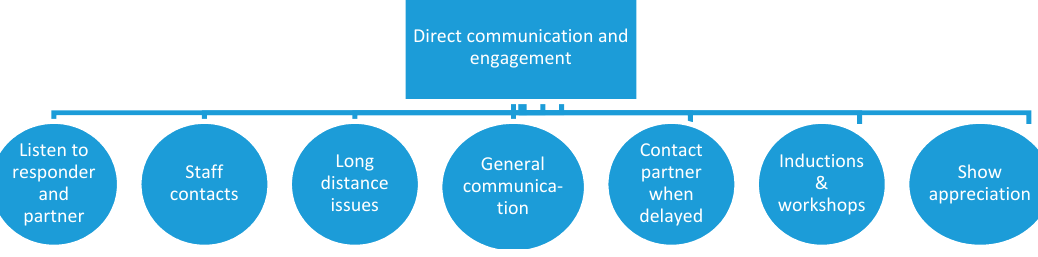
Figure 2. Themes for direct communication and engagement.